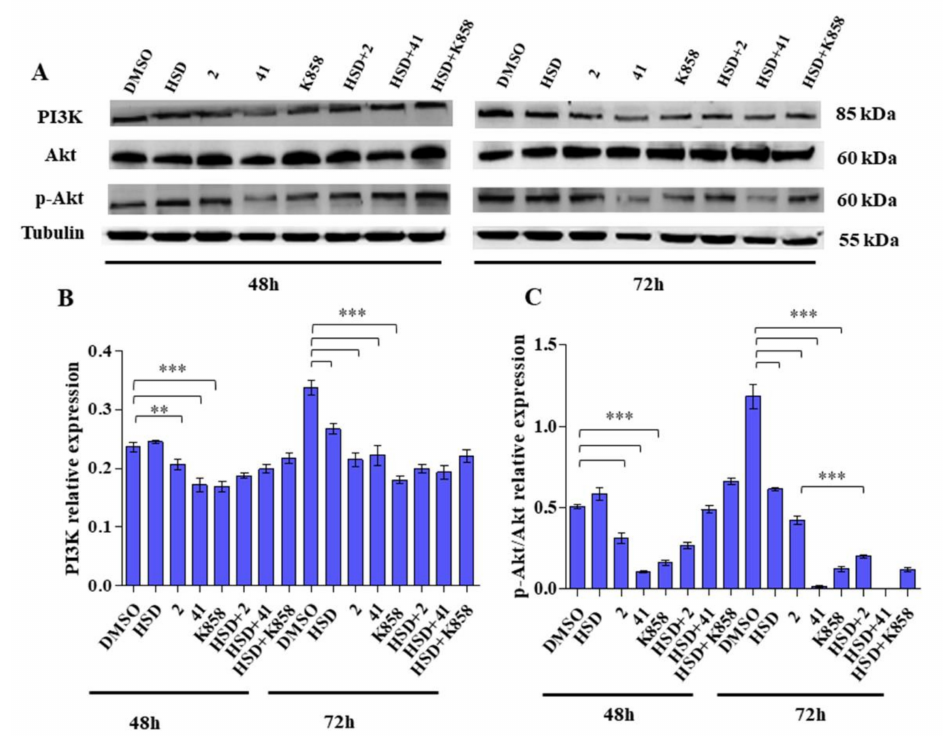
Figure 6. ( A ) PI3K and AKT expression levels in AGS cell line treated with HSD (180 µ M), 2 (1 µ M), 41 (5 µ M), K858 (1 µ M), and a combination of HSD with each Eg5 inhibitor for 48 and 72 h. DMSO 0.5%: control vehicle. Data are reported as mean ± SD of three independent experiments. Tubulin is used as a loading control. ( B , C ) The bar graph displays densitometric values expressed as mean ± SD normalized on loading control. *** p < 0.0001; ** p <